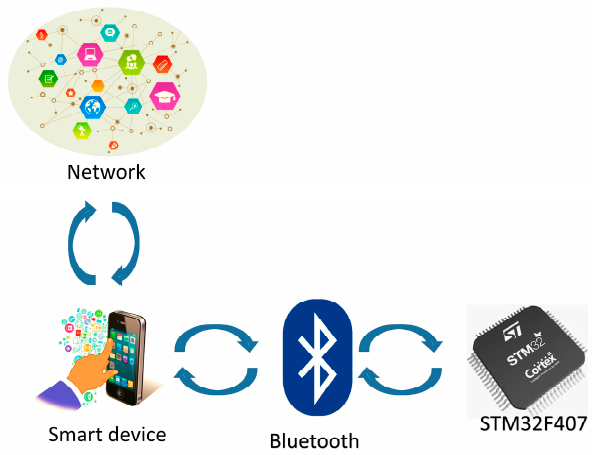
Figure 6. Data transmission module of the portable smart spectrometer.